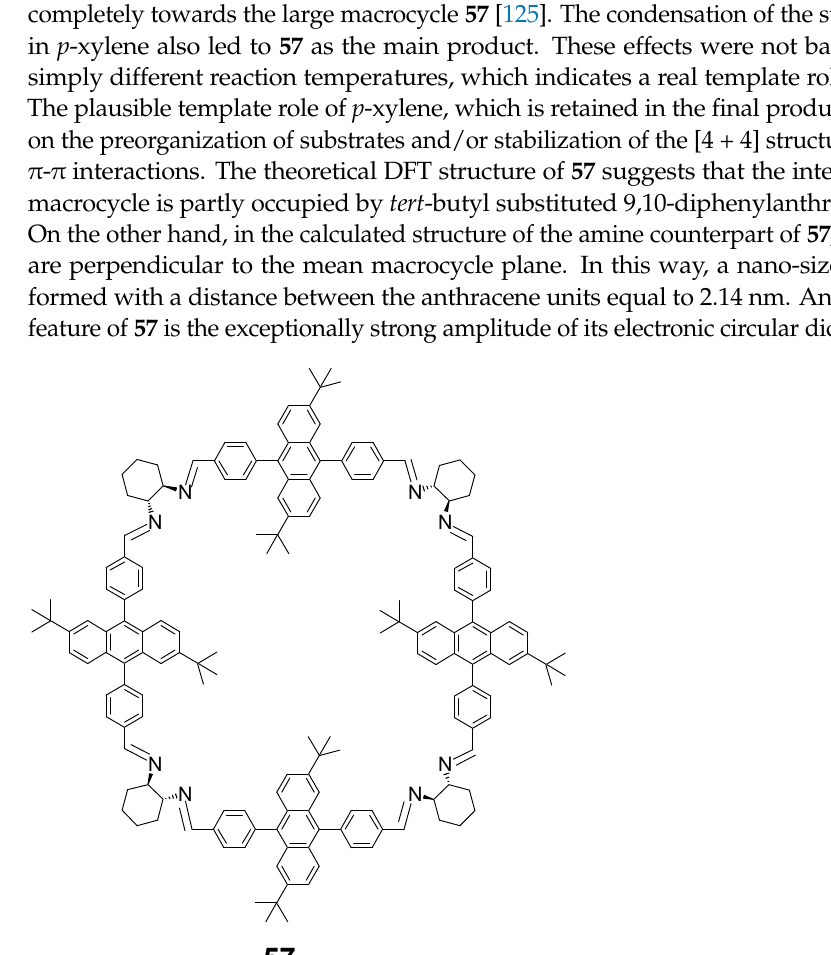
Figure 23. Molecular structure of 51 with benzene guest molecule.